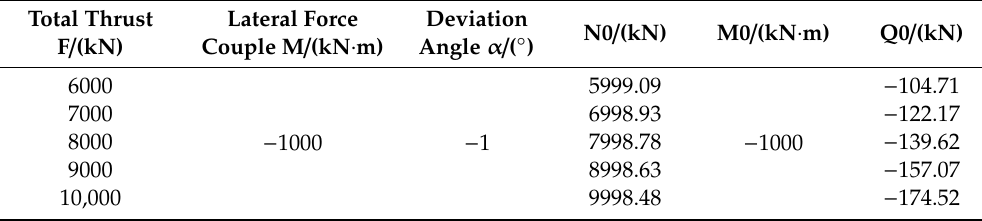
Table 2. The initial parameters under di ff erent total jack thrust.